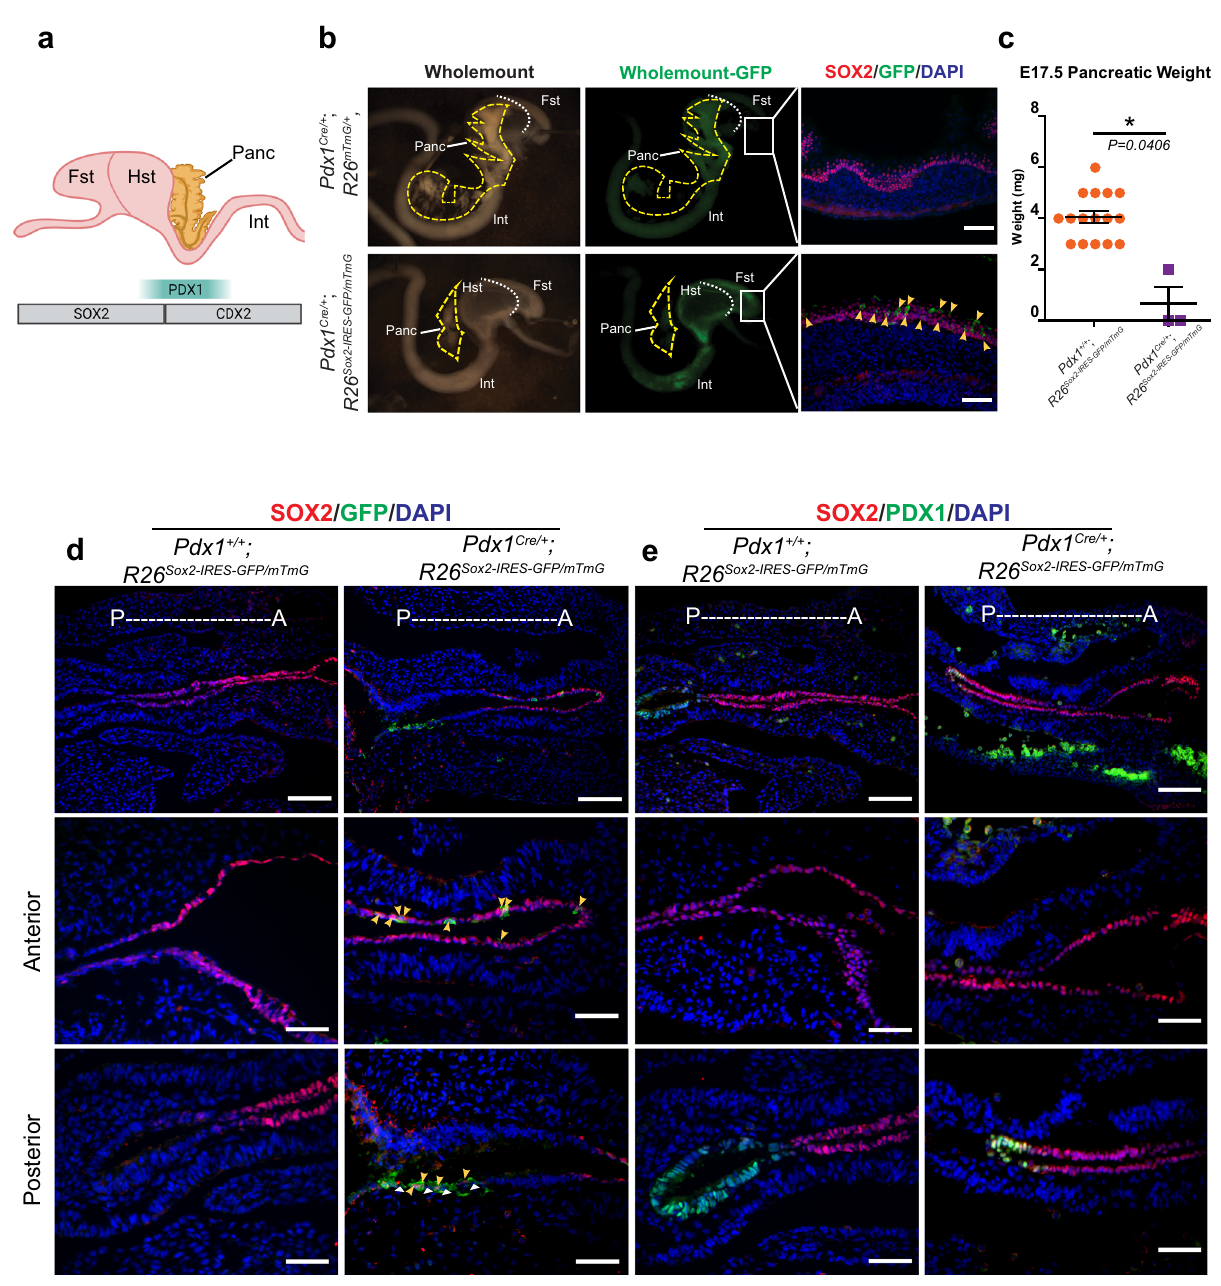
Fig. 4 Embryonic overexpression of Sox2 alters lineage fate decisions in the pancreas. a Schematic overview of SOX2, PDX1, and CDX2 expression in the developing forestomach (Fst), hindstomach (Hst), intestine (int), and pancreas (Panc). b Whole-mount light (left) and GFP (middle) images of E17.5 Pdx1 Cre/ + ; R26 mTmG/ + ( n = 3, top) and Pdx1 Cre/ + ; R26 Sox2-IRES-GFP/mTmG mice ( n = 3, bottom) with GFP (green) and SOX2 (red) immuno fl uorescence images of Fst tissue (right). White dotted line denotes the boundary between Fst and Hst. Yellow dashed lines outline the pancreas. Yellow arrowheads indicate GFP-expressing cells in the Fst. Scale bar = 50 µ m. c Mean (±SEM) pancreas weight (mg) from E17.5 Pdx1 + / + ; R26 Sox2-IRES-GFP/mTmG ( n = 16) and Pdx1 Cre/ + ; R26 Sox2-IRES-GFP/mTmG mice ( n = 3) (* P = 0.0406 using a two-sided, unpaired t-test with Welch ’ s Correction). Source data are provided as a source data fi le. d Immuno fl uorescence images of SOX2 (red) and GFP (green) in E9.5 Pdx1 + / + ; R26 Sox2-IRES-GFP/mTmG ( n = 3, left) and Pdx1 Cre/ + ; R26 Sox2-IRES-GFP/mTmG ( n = 3, right) mice. The top row shows both anterior and posterior domains (scale bar = 100 µ m), while the middle and bottom rows show the anterior and posterior domains, respectively (scale bar = 50 µ m). Yellow arrowheads indicate SOX2 and GFP double-positive cells. White arrowheads indicate GFP positive, SOX2 negative cells. e Immuno fl uorescence images of SOX2 (red) and PDX1 (green) in E9.5 Pdx1 + / + ; R26 Sox2-IRES-GFP/mTmG ( n = 3, left) and Pdx1 Cre/ + ; R26 Sox2-IRES-GFP/mTmG ( n = 3, right) mice. The top row shows both anterior and posterior domains (scale bar = 100 µ m), while the middle and bottom rows show the anterior and posterior domains, respectively (scale bar = 50 µ